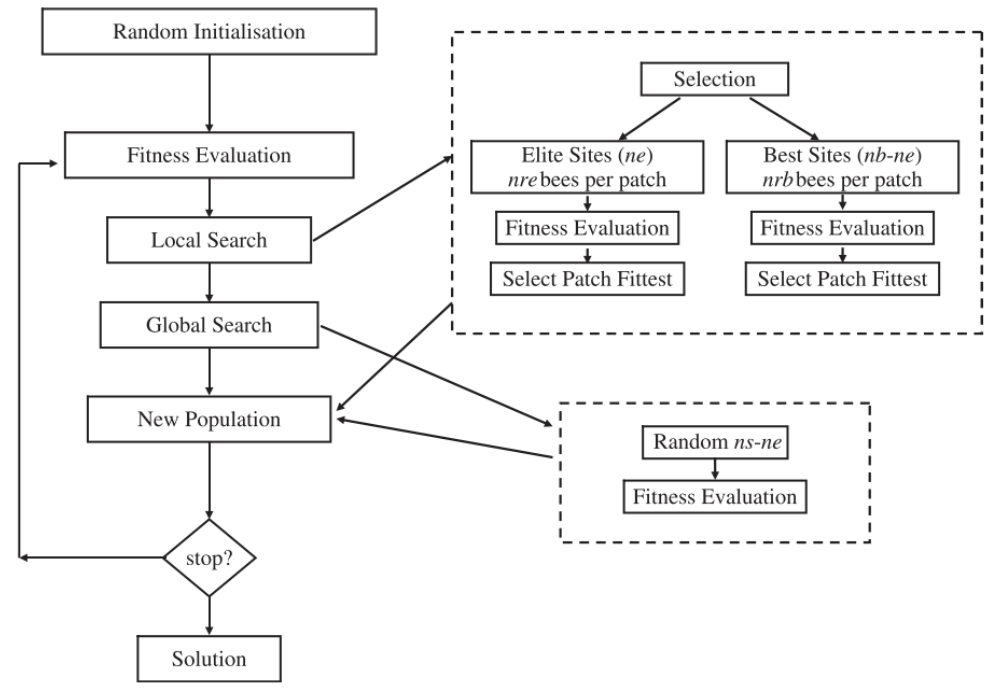
Figure 1: Flowchart of the Bees